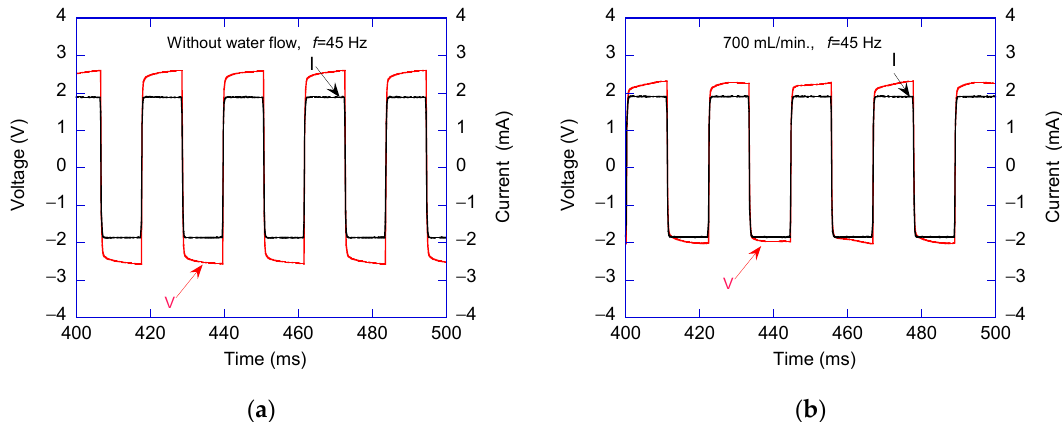
Figure 5. Waveforms of voltage (P1, P2) and square current of 45 Hz applied to soil: ( a ) without water flow; ( b ) with water flow at a rate of 700 mL/min.